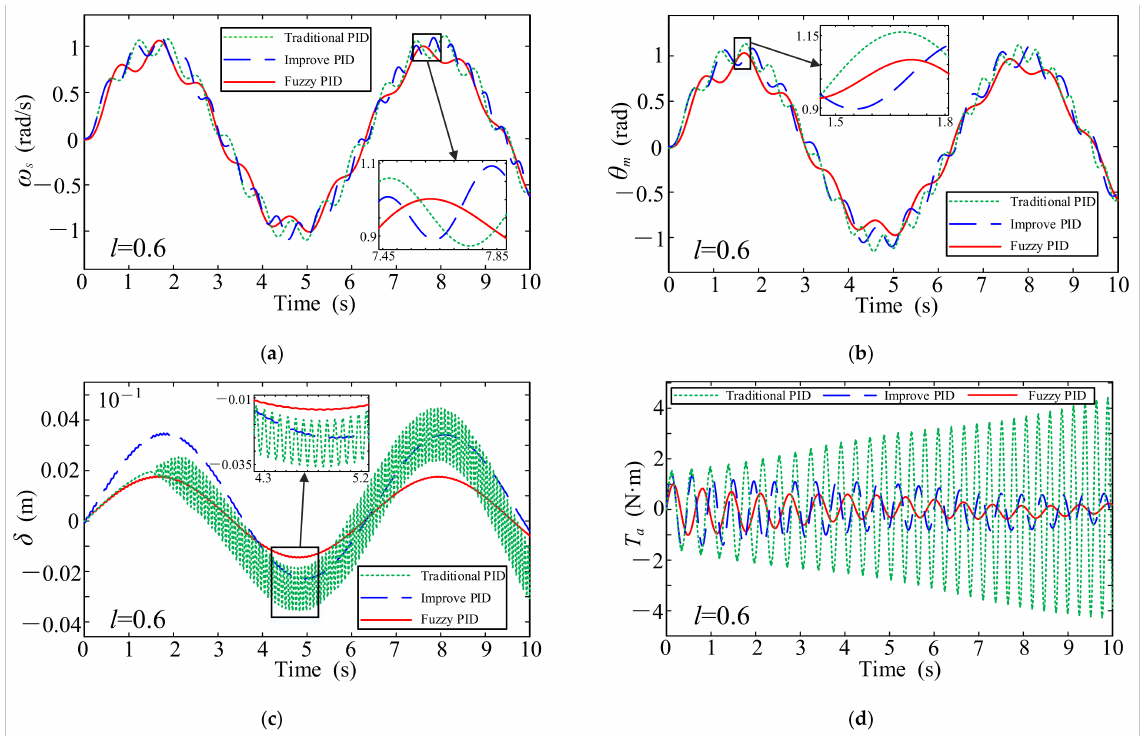
Figure 7. The output curve of the flexible load side in case 2: ( a ) the output speed; ( b ) the output angle; ( c ) output elastic deformation; ( d ) the output